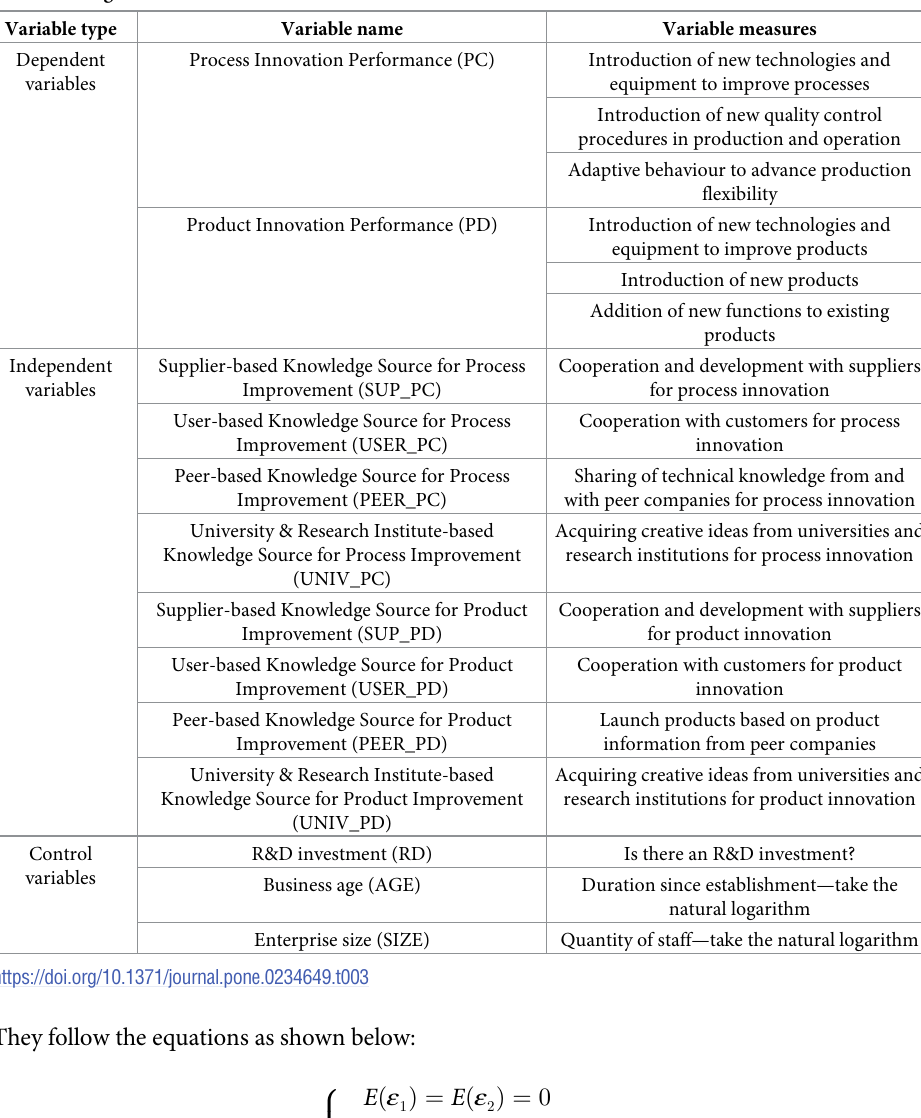
Table 3. Design of